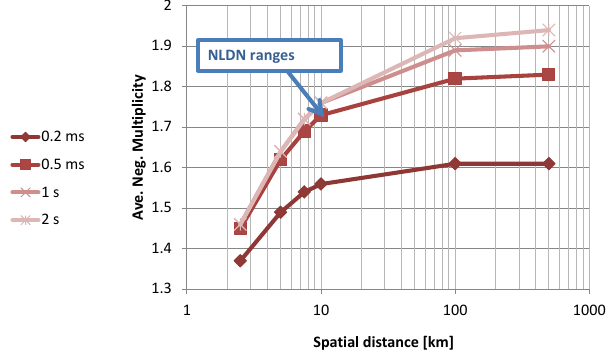
Fig. 3. Average multiplicity of negative cloud-to-ground flashes as a function of maximum stroke separation distance for a range of inter-stroke time intervals.